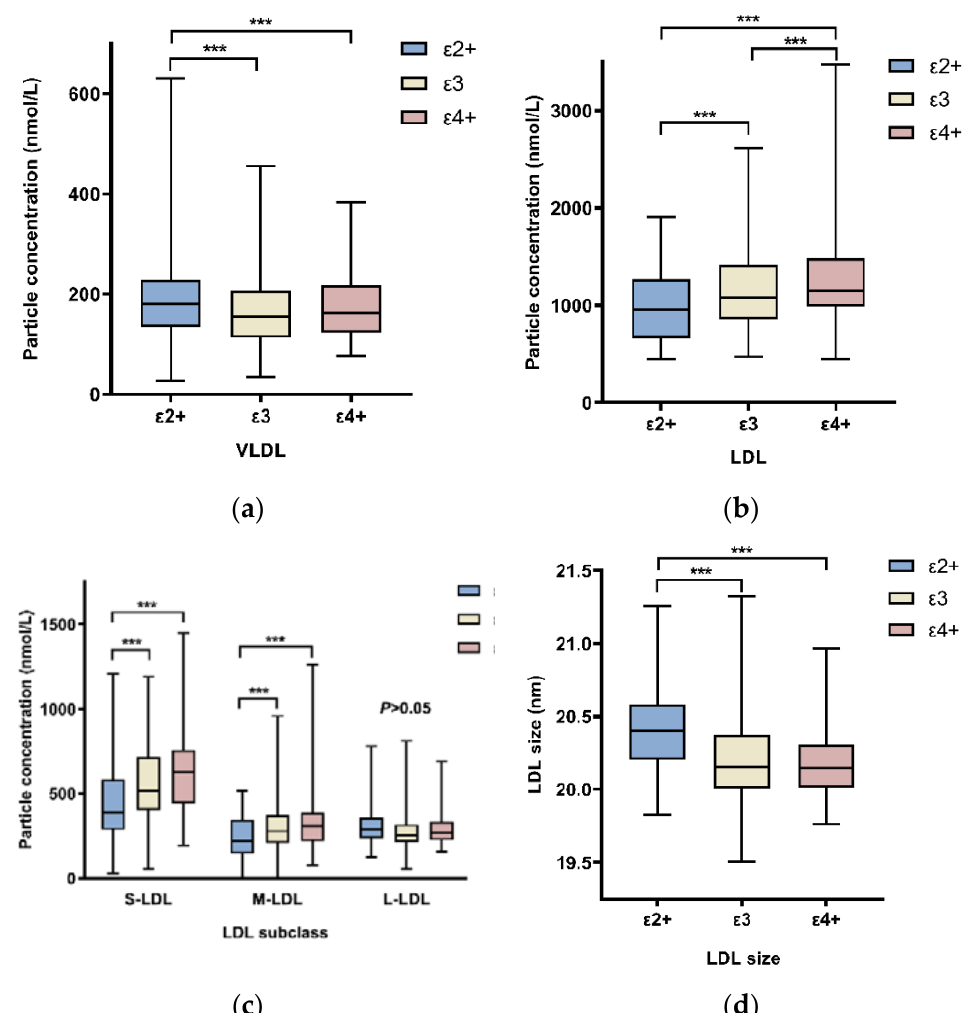
Figure 1. Comparison of lipoprotein particle concentrations and LDL size among three groups of differing APOE genotypes. One-way analysis of variance test was used to compare the means of continuous variables. ( a ) Comparison of VLDL particle concentrations. ( b ) Comparison of LDL particle concentrations. ( c ) Comparison of LDL subclass particle concentrations. ( d ) Comparison of LDL size. ***: p -value < 0.05. For clarity of illustration, only analysis results with p < 0.05 are shown here. Abbreviations: VLDL, very low-density lipoprotein; LDL, low-density lipoprotein; S-LDL, small low-density lipoprotein; M-LDL, median low-density lipoprotein; L-LDL, large low- density